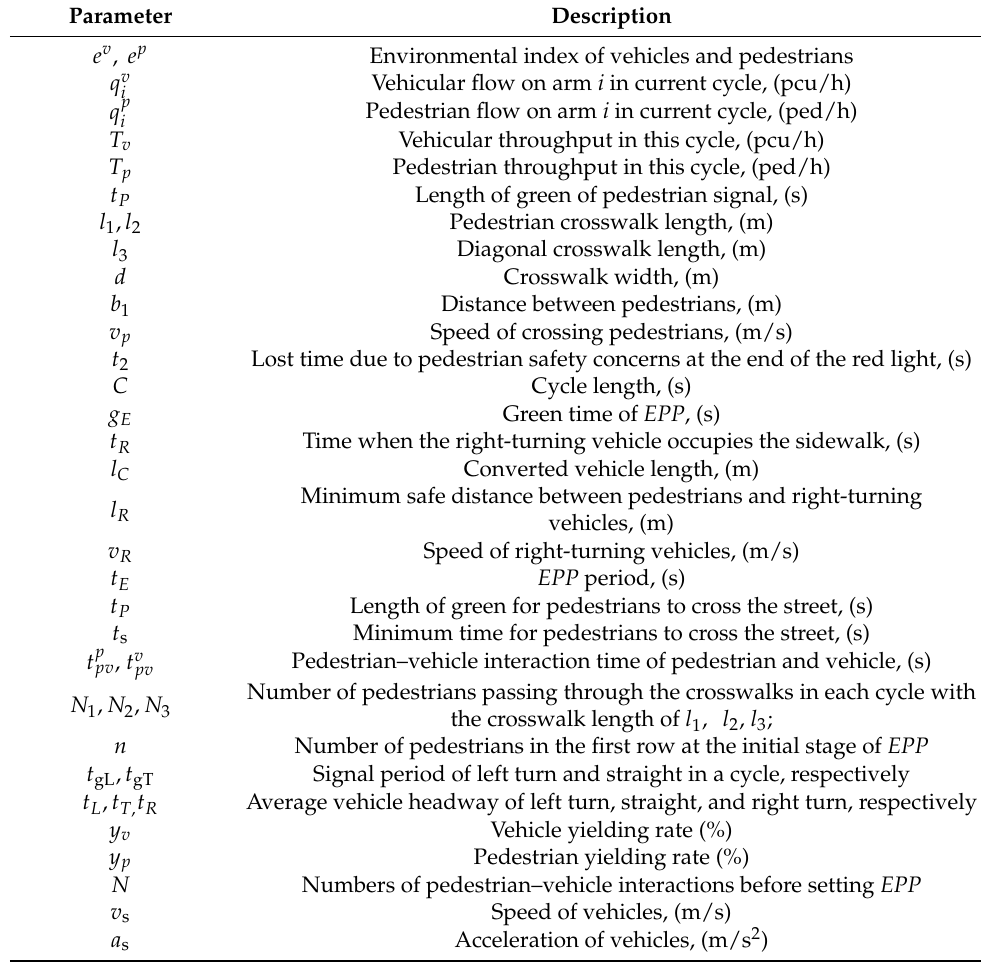
Table A1. Notation and parameter